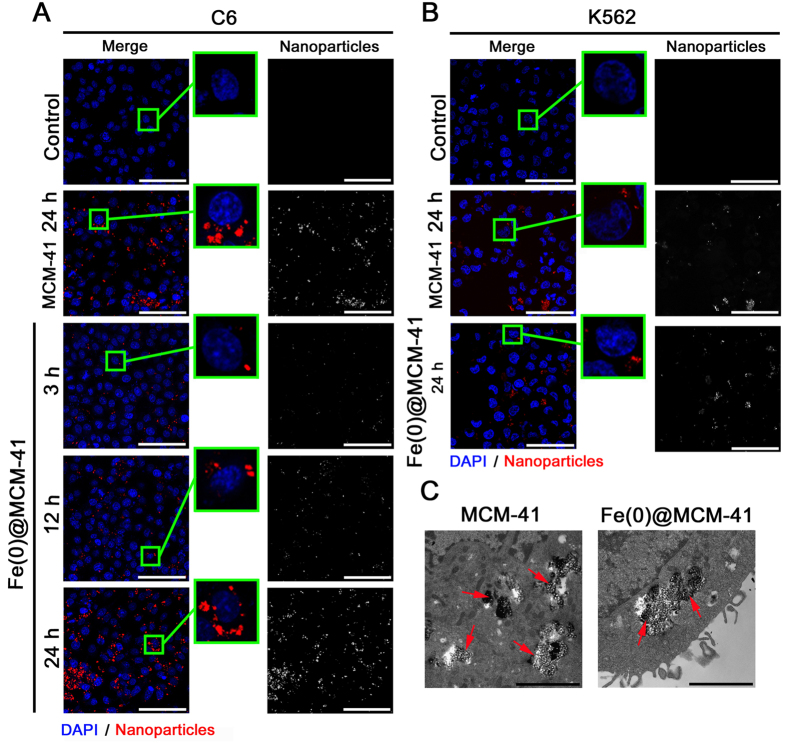
Cellular interactions of MSNs.(A) Immunofluorescent images of C6 cells following 24 hours incubation with PBS, MSNs and Fe-MSNs. Nuclei were stained with DAPI (blue). Nanoparticles were detected by reflecting laser scanning at 488 nm (red). Scale bar, 10 μm. (B) Immunofluorescent images of K562 cells following 24 hours of incubation with PBS, MCM-41 and Fe(0) @ MCM-41 particles. (C) Transmission electron microscopy of the C6 cells co-incubated with MSNs and Fe(0) @ MCM-41 particles. Scale bar, 200 nm.